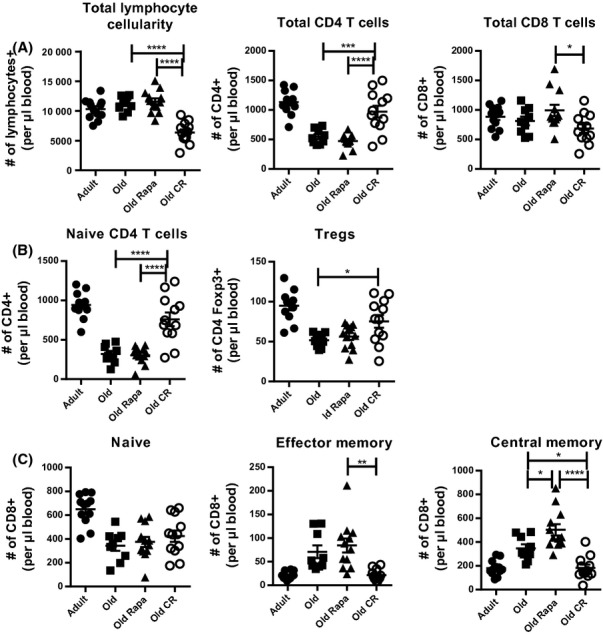
Rapamycin and calorie restriction differently alter peripheral T-cell subset absolute counts. Mice were bled after 2 months of rapa feeding when O mice were 18 months old. (A) Total lymphocyte, total CD4, and total CD8 T-cell absolute counts in the blood. (B) Absolute counts of N (CD44lowCD62Lhi) and regulatory (Foxp3+) CD4 T cells in the blood. (C) N, CM, and EM cells were identified enumerated based on CD44 and CD62L expression. Data are shown as mean ± SEM and are representative of 3 independent cohorts. Statistical differences between O groups were calculated by 1-way ANOVA with Bonferroni post-tests. Adults are shown to provide a reference point and were not included in statistical analyses. *P<0.05; **P<0.01; ***P<0.001.